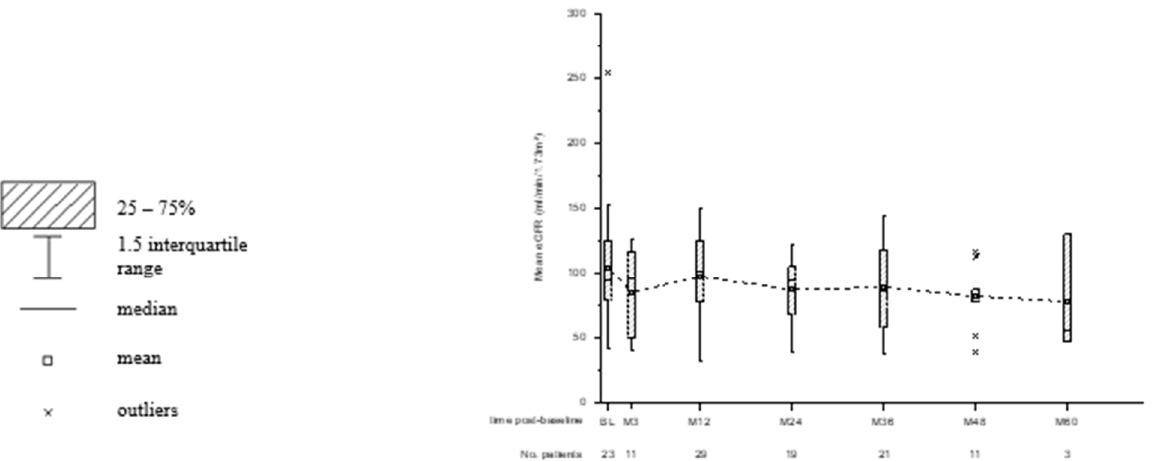
Figure 2. Box and whisker plots for the observed course of eGFR. Time post-baseline is presented in weeks (W) and months (M). The number of patients with available data for each point of interest is displayed below.